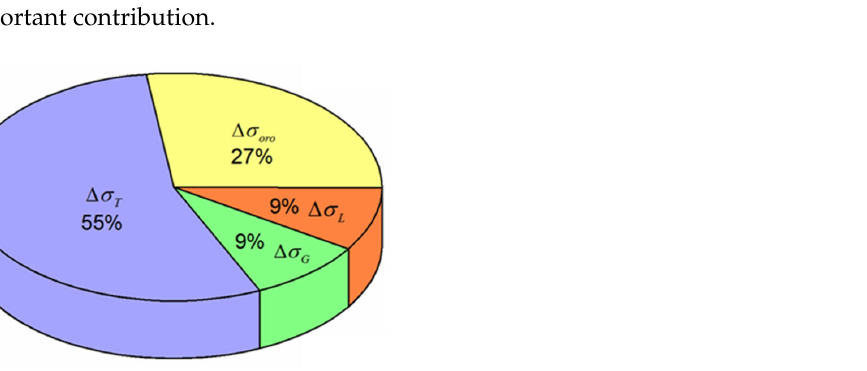
Figure 12. The proportion of each strengthening mechanism in nano ‐ AlN/AA6061 nanocomposites.